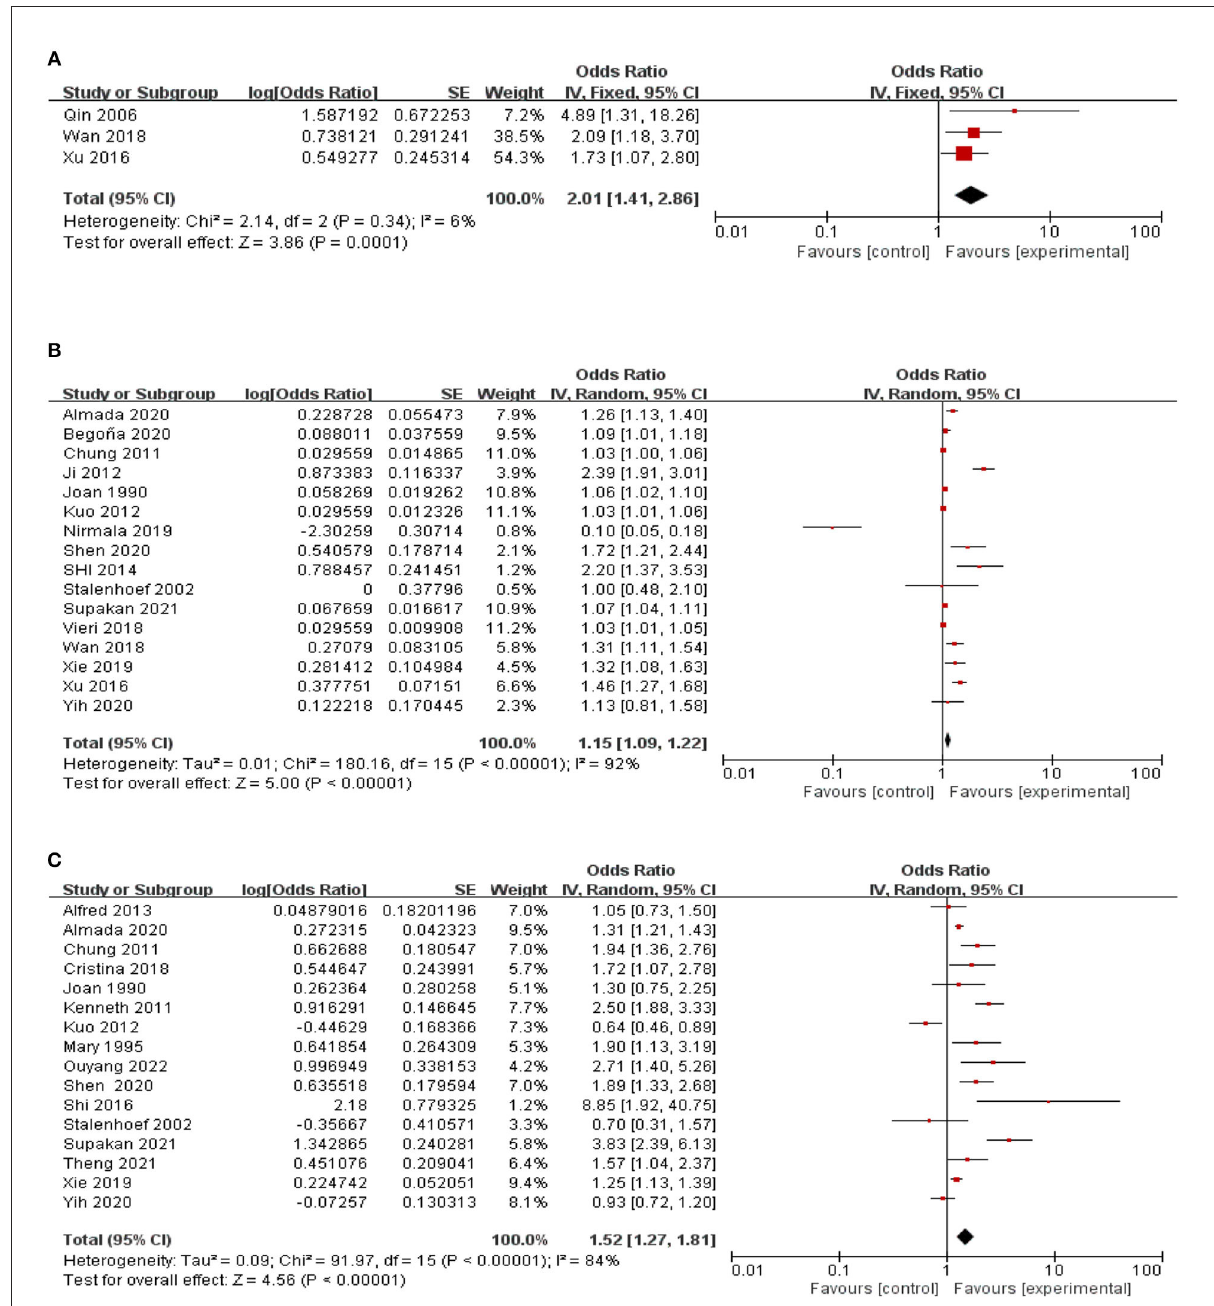
FIGURE2 A forest plot for the association between falls among community-dwelling older adults. (A) Dementia. (B) Age. (C) Female.